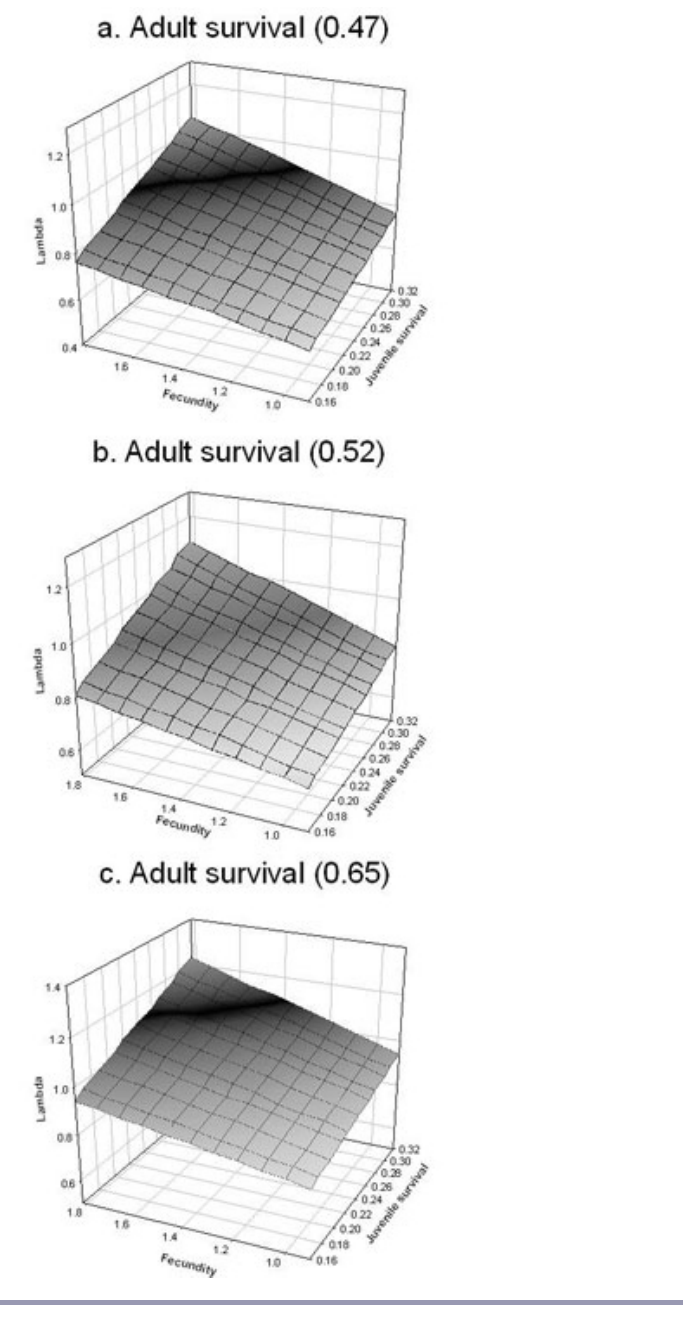
Fig. 5 . Predicted values of l for Streaked Horned Larks in western Washington, USA, as fecundity and juvenile survival are simultaneously increased by increments of 10% starting with current empirical levels of 0.91 for fecundity and 0.17 for juvenile survival. The x and y axes show the value for fecundity and juvenile survival after each iteration. Adult survival of female Streaked Horned Larks was held constant at its current empirical level of 0.47 (a), increased by 10% to 0.52 (b), and increased to 0.65 (c), the level of Pallid Horned Larks in northern British Columbia, Canada (Camfield et al.